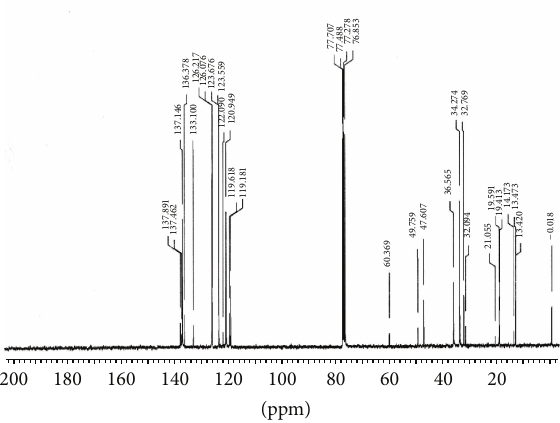
Figure 3: 13 C-NMR spectra of